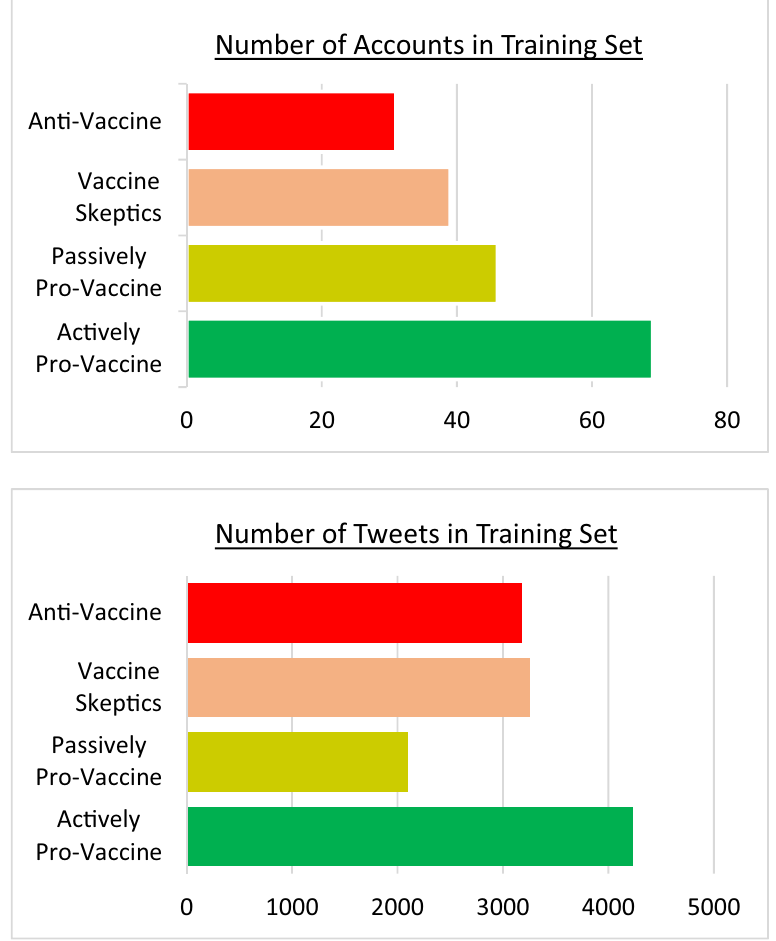
Figure 7. Number of accounts per category (top) and corresponding number of tweets per category (bottom) used to train our machine learning algorithm. We selected more accounts favoring vaccination than disfavoring vaccination because the former tweets less often than the latter. As a result, the total number of tweets that favor vaccination (Actively or Passively Pro-Vaccine) in the training set is similar to the total number of tweets that disfavor vaccination (Anti-Vaccine or Vaccine Skeptics) in the training